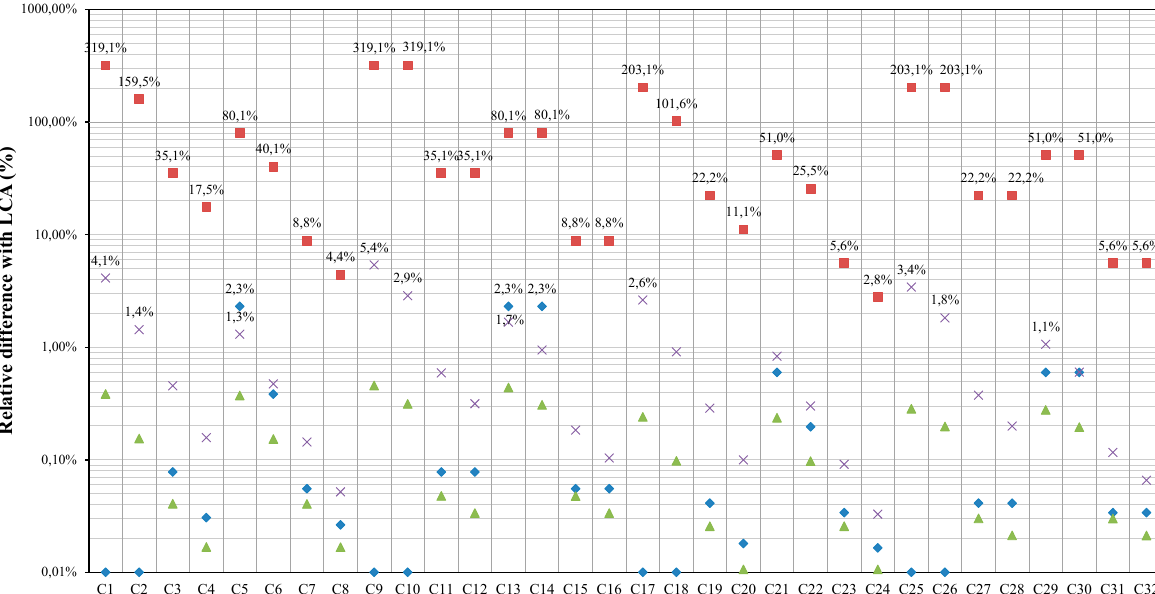
Figure 6. Relative difference with LCA for 2ah (advanced efficiency level ventilated façade system with high embodied energy products) and 3al (advanced efficiency level external insulation system with low embodied energy products) refurbishment